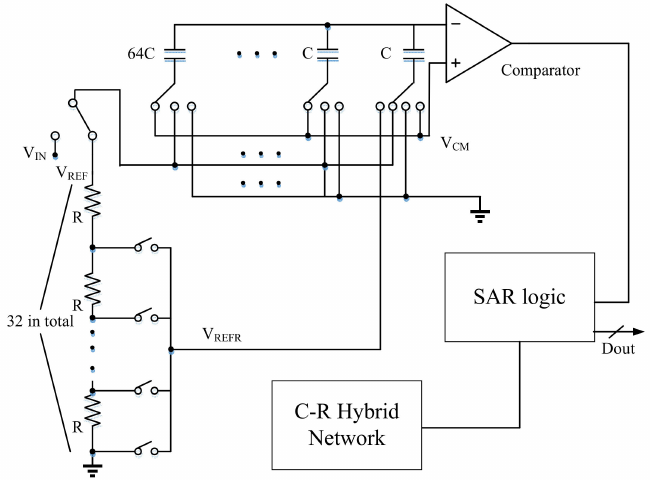
Figure 4. Topology diagram of 12-bit SAR ADC based on C-R network.